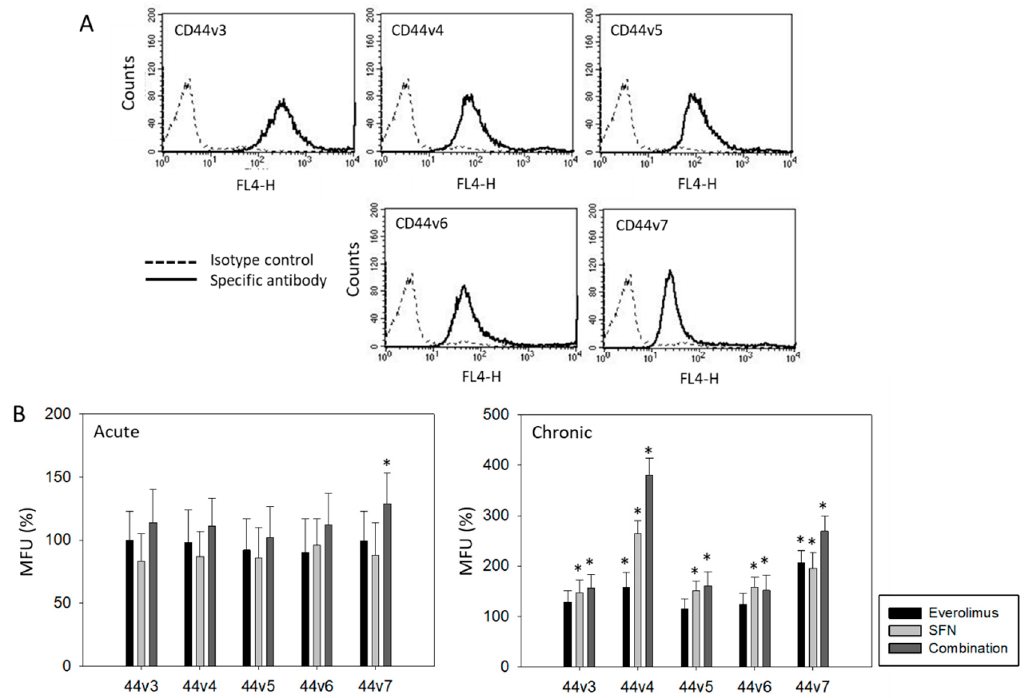
Figure 3. ( A ) Surface expression of CD44 variants v3-v7 on RT112 cells. Counts indicate MFU (mean fluorescence units). One representative of three separate experiments is shown. Solid line: specific fluorescence; dashed line: isotype IgG1-APC. ( B ) expression level of CD44 variants v3-v7 following sulforaphane (SFN) or everolimus + sulforaphane (combination) exposure. All values are means related to untreated controls set to 100% and bars indicate standard deviation. * indicates significant di ff erence to corresponding control, p ≤ 0.05, n =